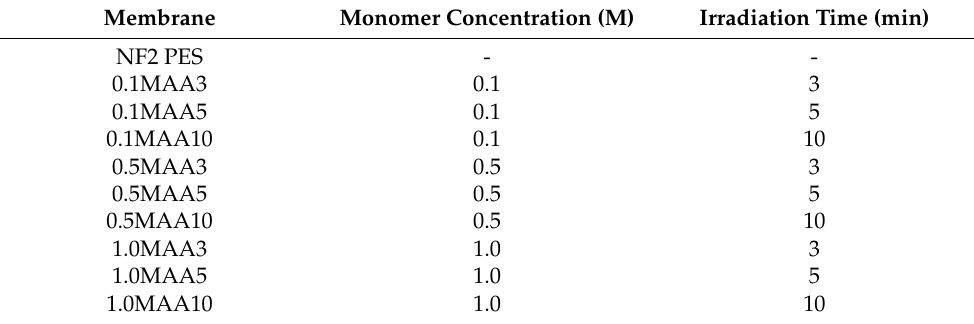
Table 2. Prepared membranes and modification